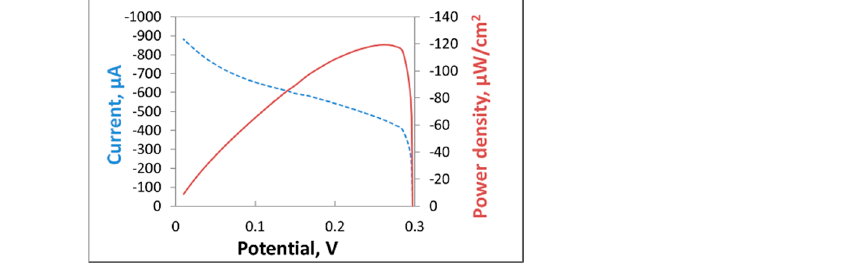
electrode. Figure S4: Cyclic voltammetry in oxygen-free PBS solution of LDG-CH4 bioelectrode with increasing glucose concentration in the absence (A) and in the presence (B) of the inhibitor Ag + . Voltammograms acquired at 0.1